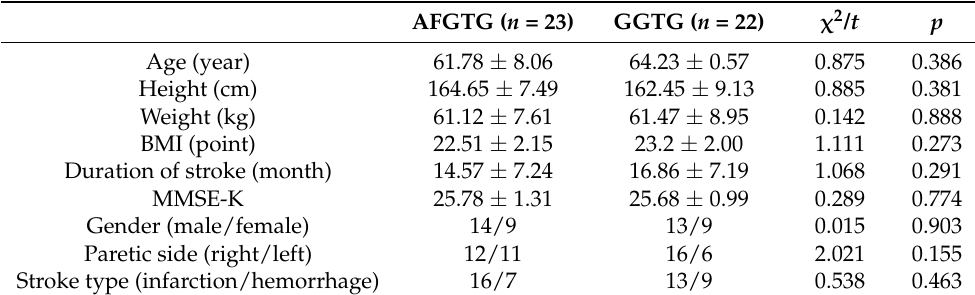
Table 1. General Characteristics of Subject ( n =